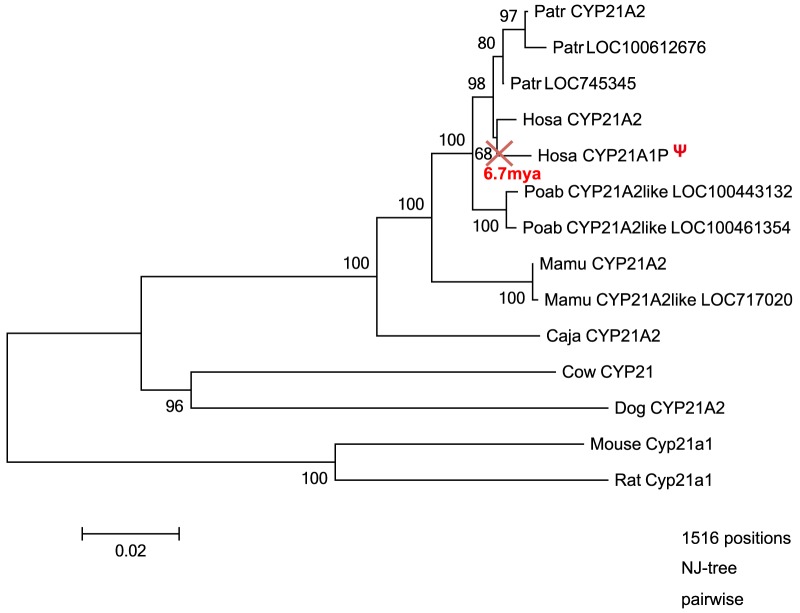
Time of pseudogenization of CYP21A1P in humans.The phylogenetic tree was obtained using the NJ method, using the CDS. The pseudogene is represented by Ψ. The cross shows the time at which function was lost.